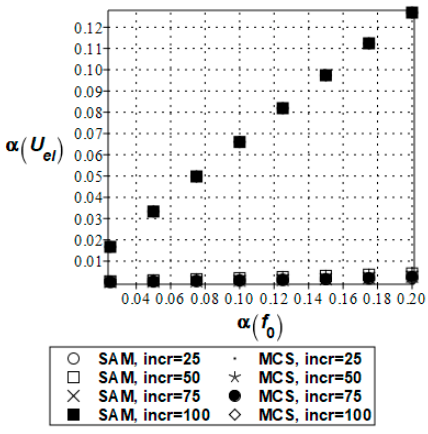
Figure 7. Coefficients of variation of elastic energy fluctuations. Figure 7. Coe ffi cients of variation of elastic energy